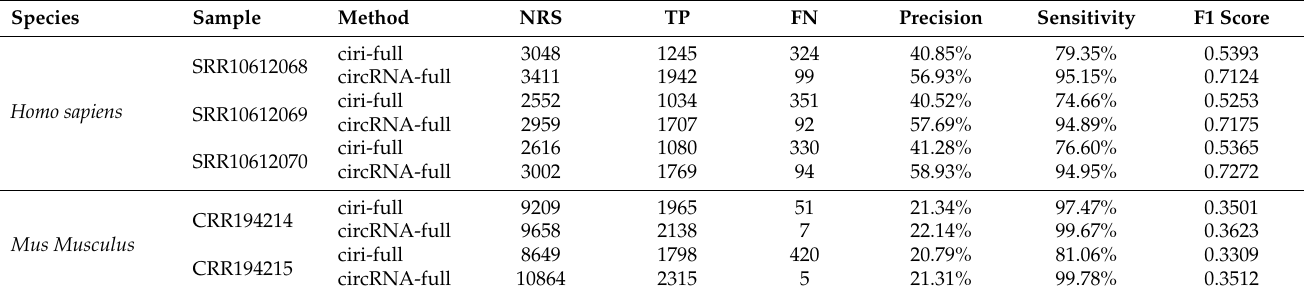
Table 2. Performance comparison of ciri-full and circRNA-full using different accuracy measures.